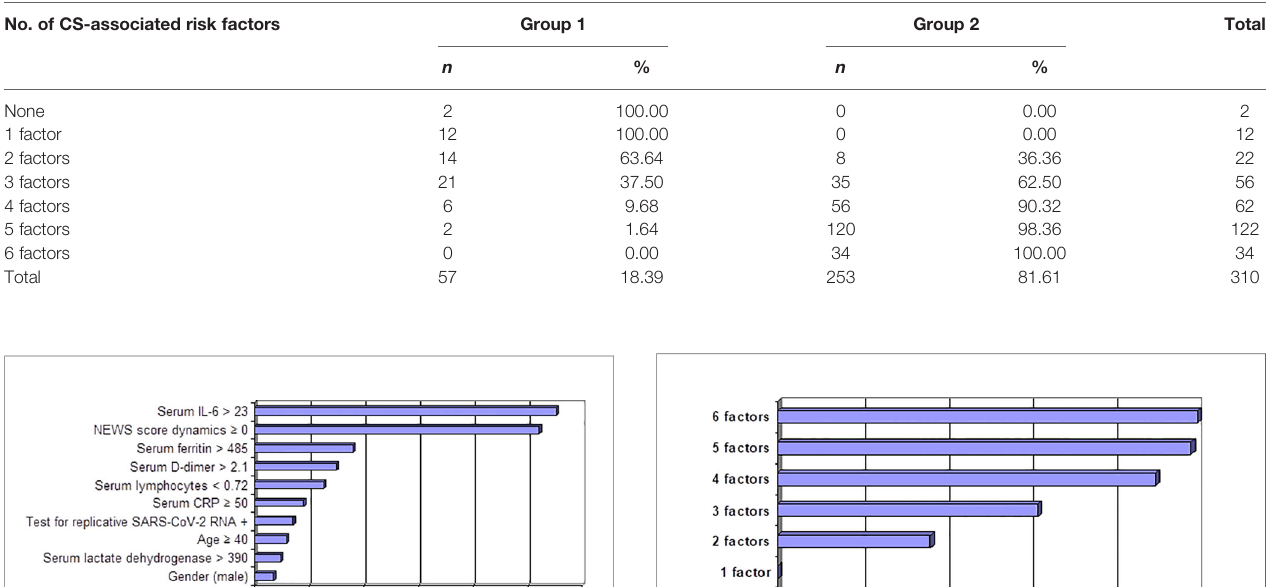
TABLE 6 | CS incidence rate depending on the number of risk factors.